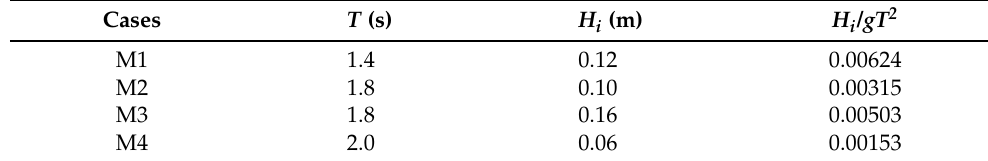
Table 6. Simulated cases with irregular waves.